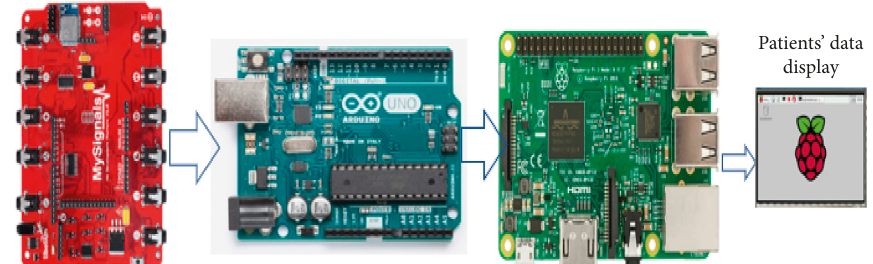
Figure 2: MySignals hardware interfaced with Arduino and Raspberry Pi 3 for patients’ data